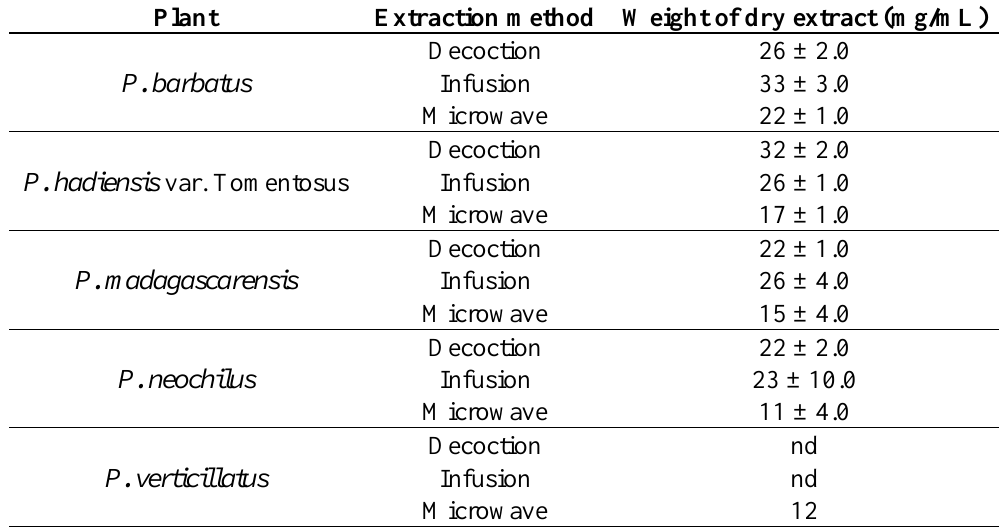
Table 1. Aqueous extract dry weights for each Plectranthus species and extraction